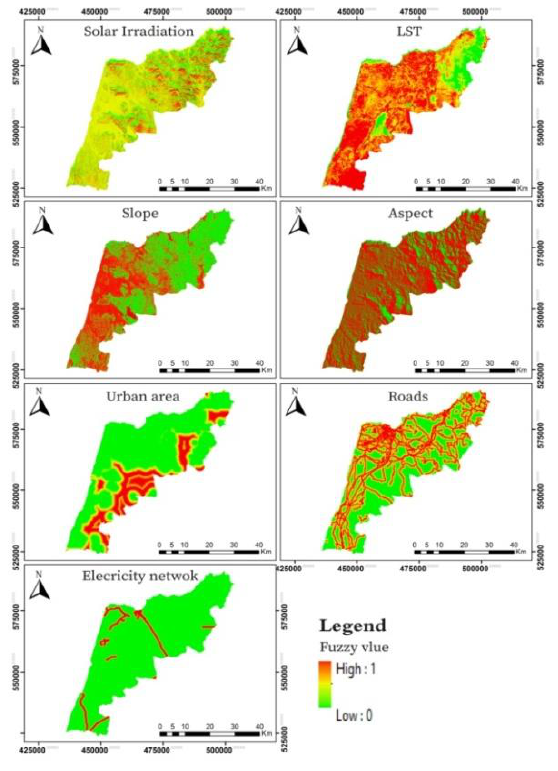
Figure 3. Produced maps by fuzzy model